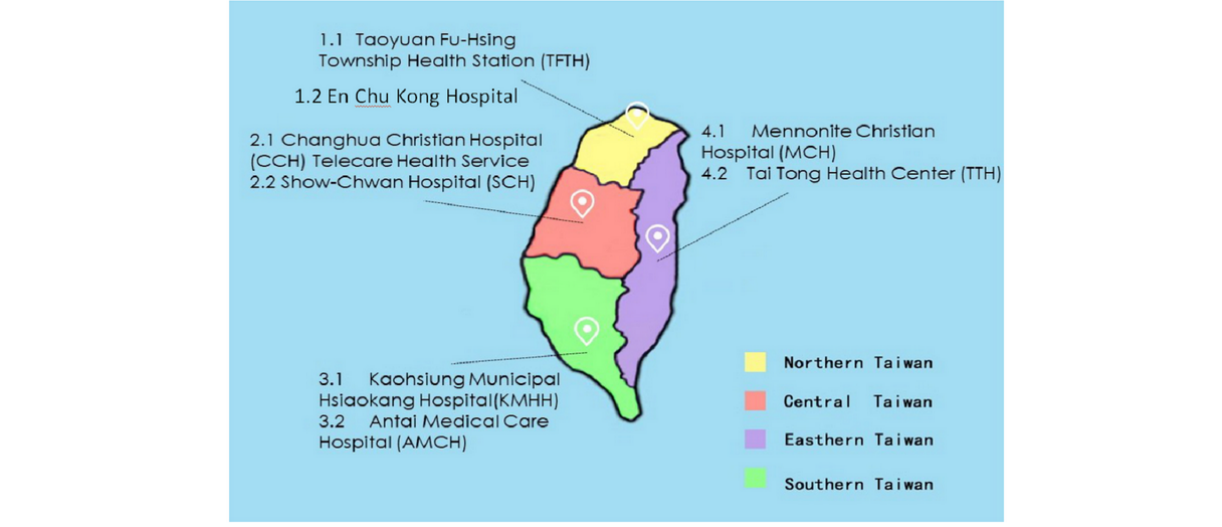
Figure 2. Remote health settings in Northern, Central, Southern, and Eastern Taiwan.